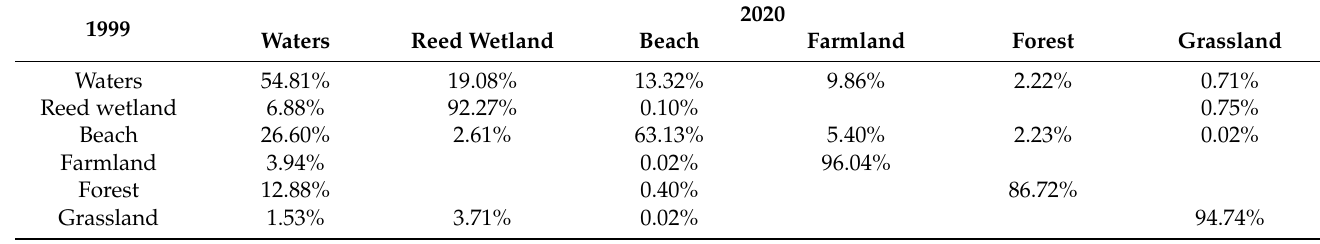
Table 3. Land use transfer matrix from 1999 to 2020.